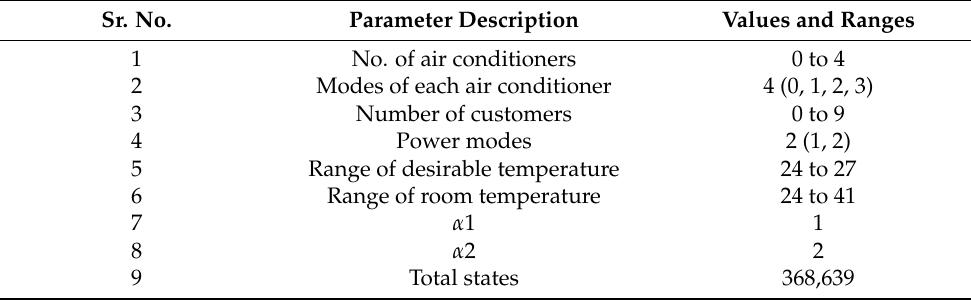
Table 1. Parameter values for thermal control. Sr. No. Parameter